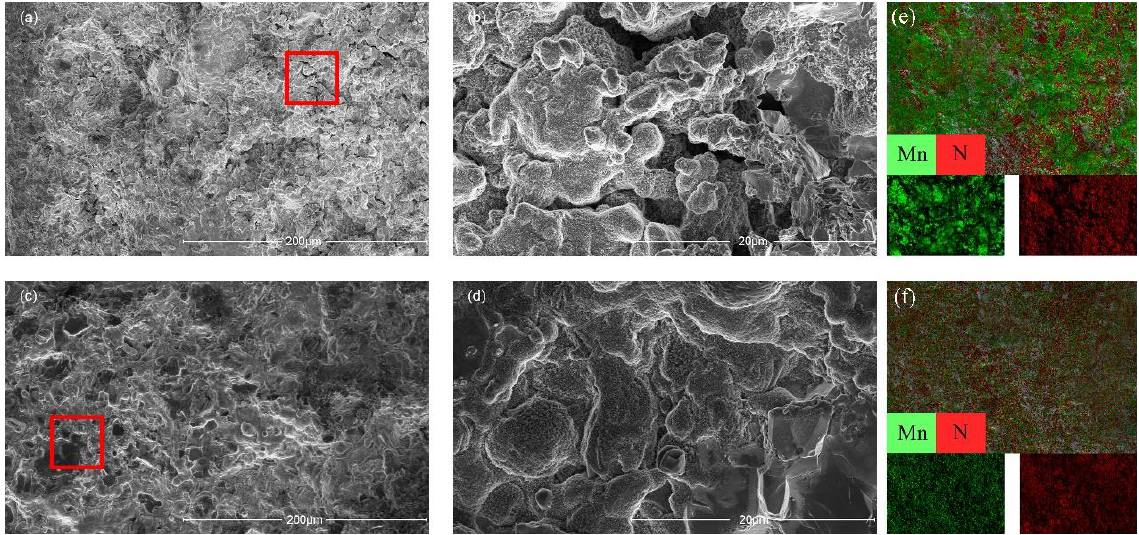
Figure 2. ( a ) A full view of a randomly selected area after the initial synthesis of the sample; ( b ) the enlarged view of the red frame region in ( a ); ( c ) the overall view of another randomly selected region of the sample after secondary sintering and annealing; ( d ) the enlargement of the red frame region of ( c ); ( e ) the element distribution diagram of the initial synthesized EDS of the sample; ( f ) the element distribution diagram of the sample after secondary sintering and annealing by EDS.